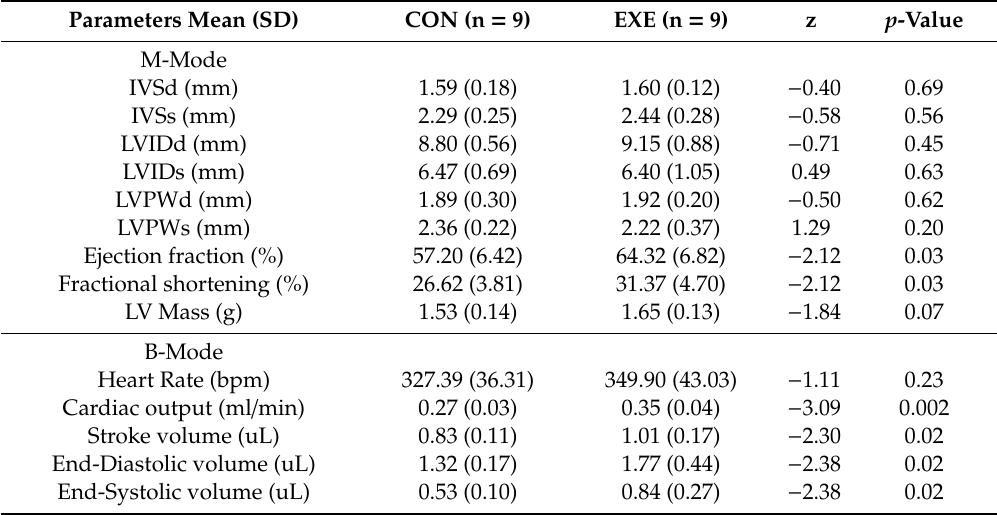
Table 4. Description of the echocardiogram variables between the control and exercise group.